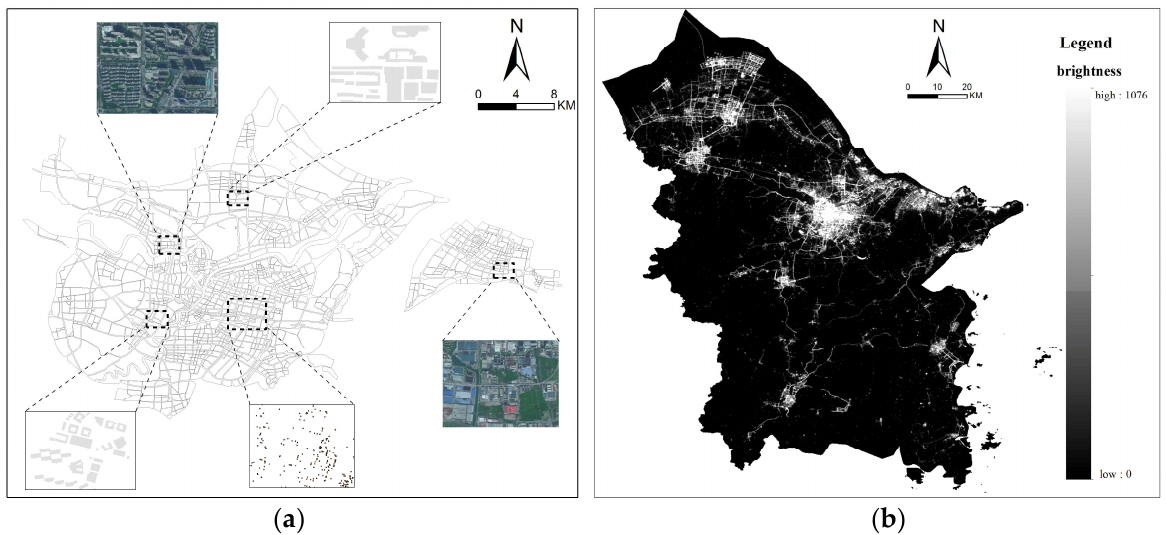
Figure 2. ( a ) The research units segmented by OpenStreetMap network, remote sensing images, POIs and building footprints in some sample units. ( b ) Night lights in Ningbo